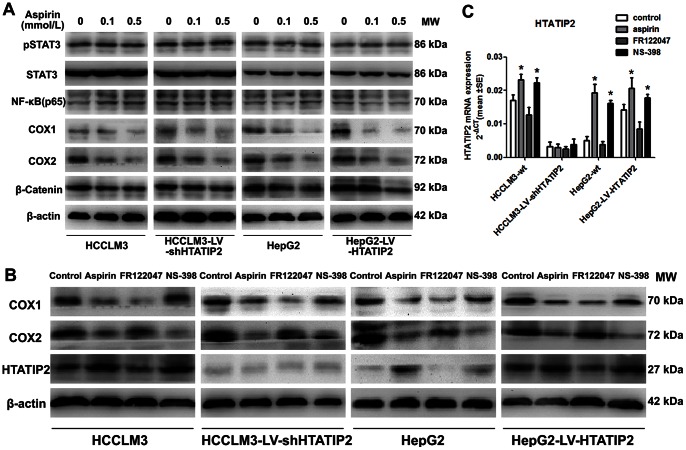
Aspirin up-regulated HTATIP2 by inhibiting COX2 expression.(A) Western blotting revealed that aspirin down-regulated COX1 and COX2 expression in HCC cell lines. (B) After 12 hours of treatment, Western blotting revealed a down-regulation of COX2 expression by aspirin, and NS-398 corresponded with an increase in HTATIP2. (C) The up-regulation of HTATIP2 mRNA by aspirin and NS-398 was confirmed by real-time PCR (columns, mean of 6 samples in each group; bars, SEM; *, P<0.05).